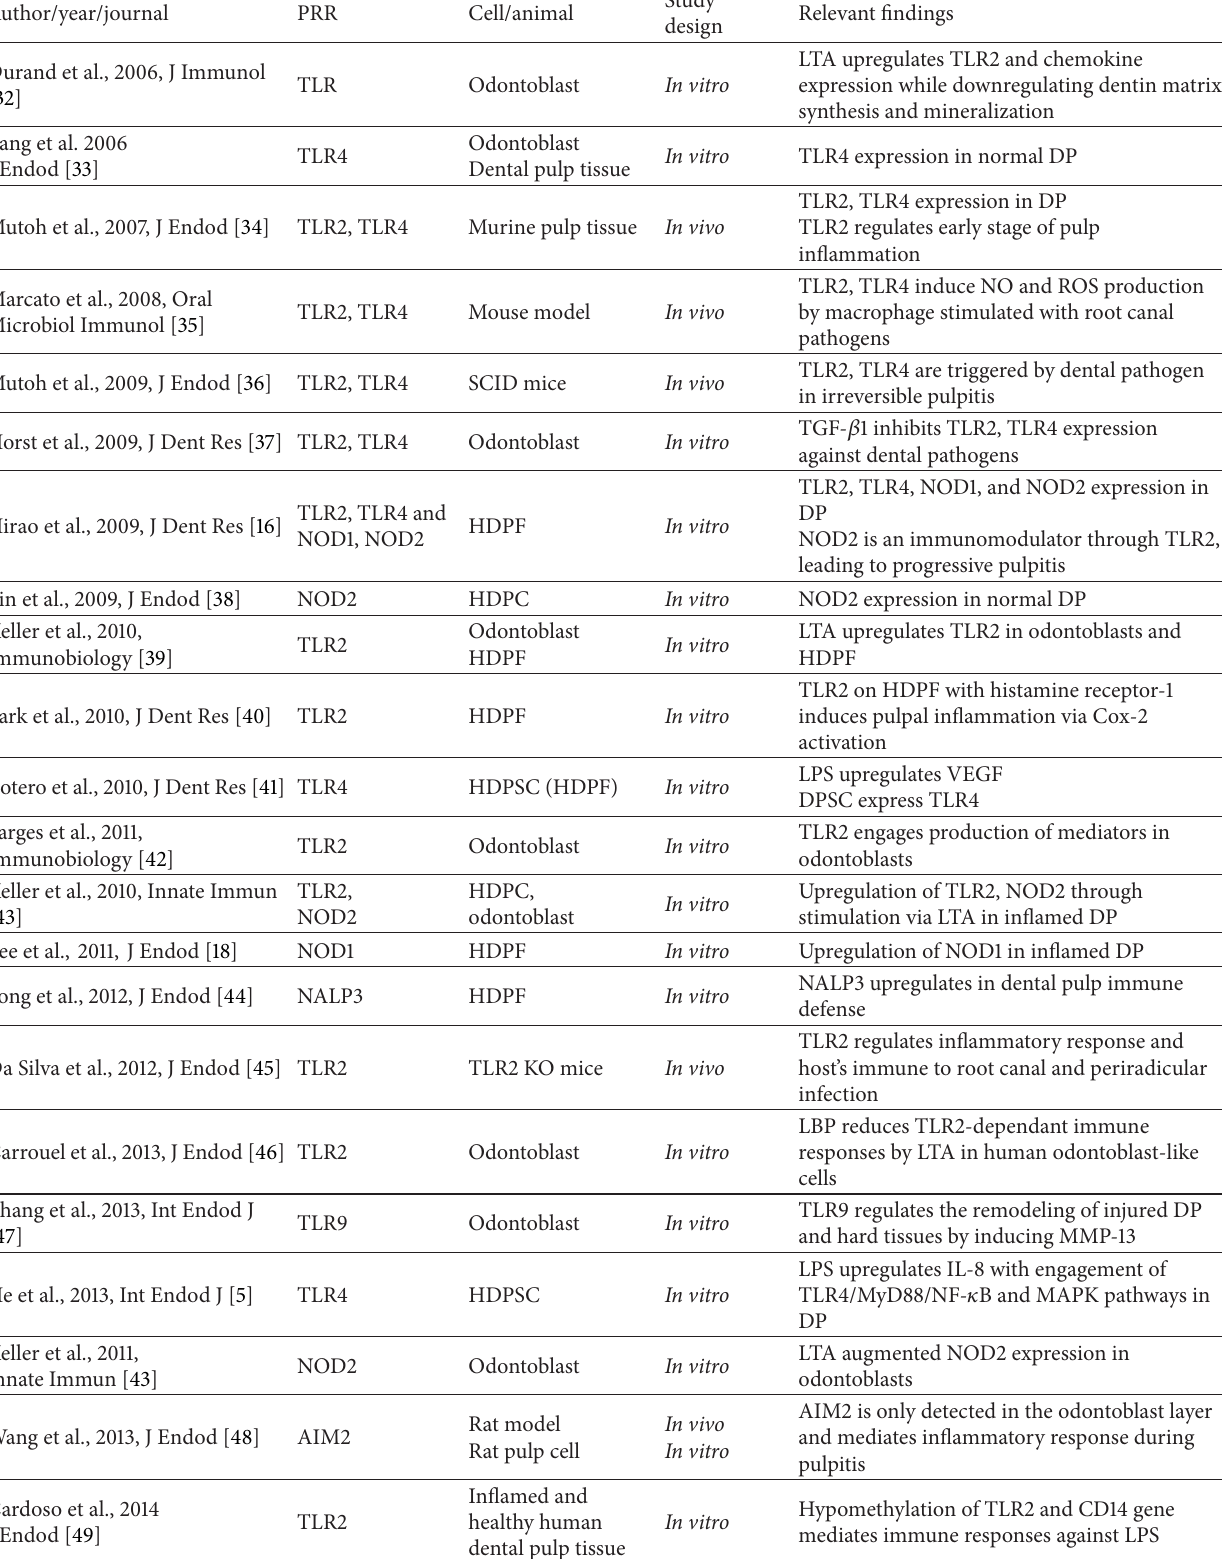
Table 2: Summary of recent finding with PRR in dental